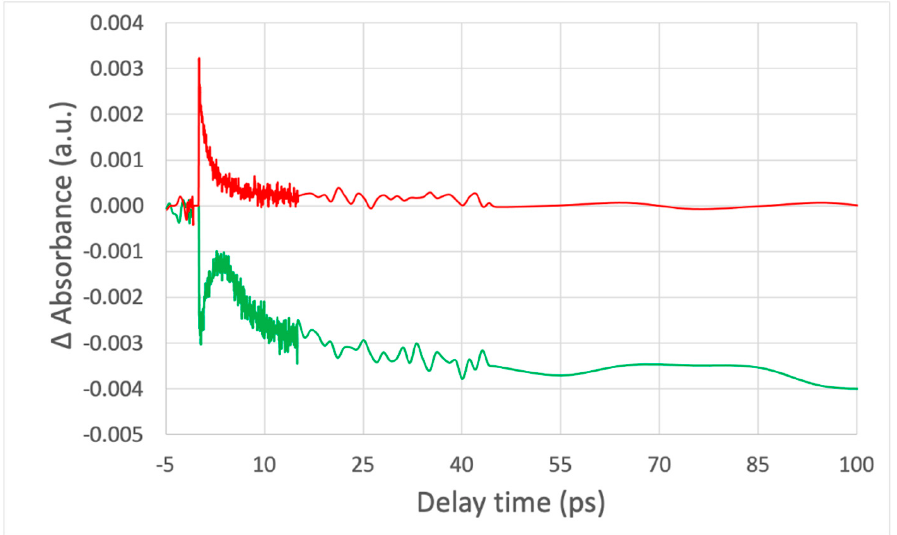
Figure 10. Kinetic trace extract at 350 nm after excitation of Au plasmon at 620 nm for FTO/Au NPs/p-Cu 2 O (green trace). For comparison purposes the signal is overlapped with the trace extracted at the winglet for FTO/Au NPs/p-Cu 2 O (red trace).